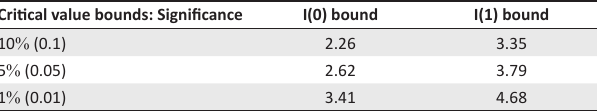
TABLE 4b: Bound test for the presence of co-integration in auto-regressive distributed lag. Critical value bounds: